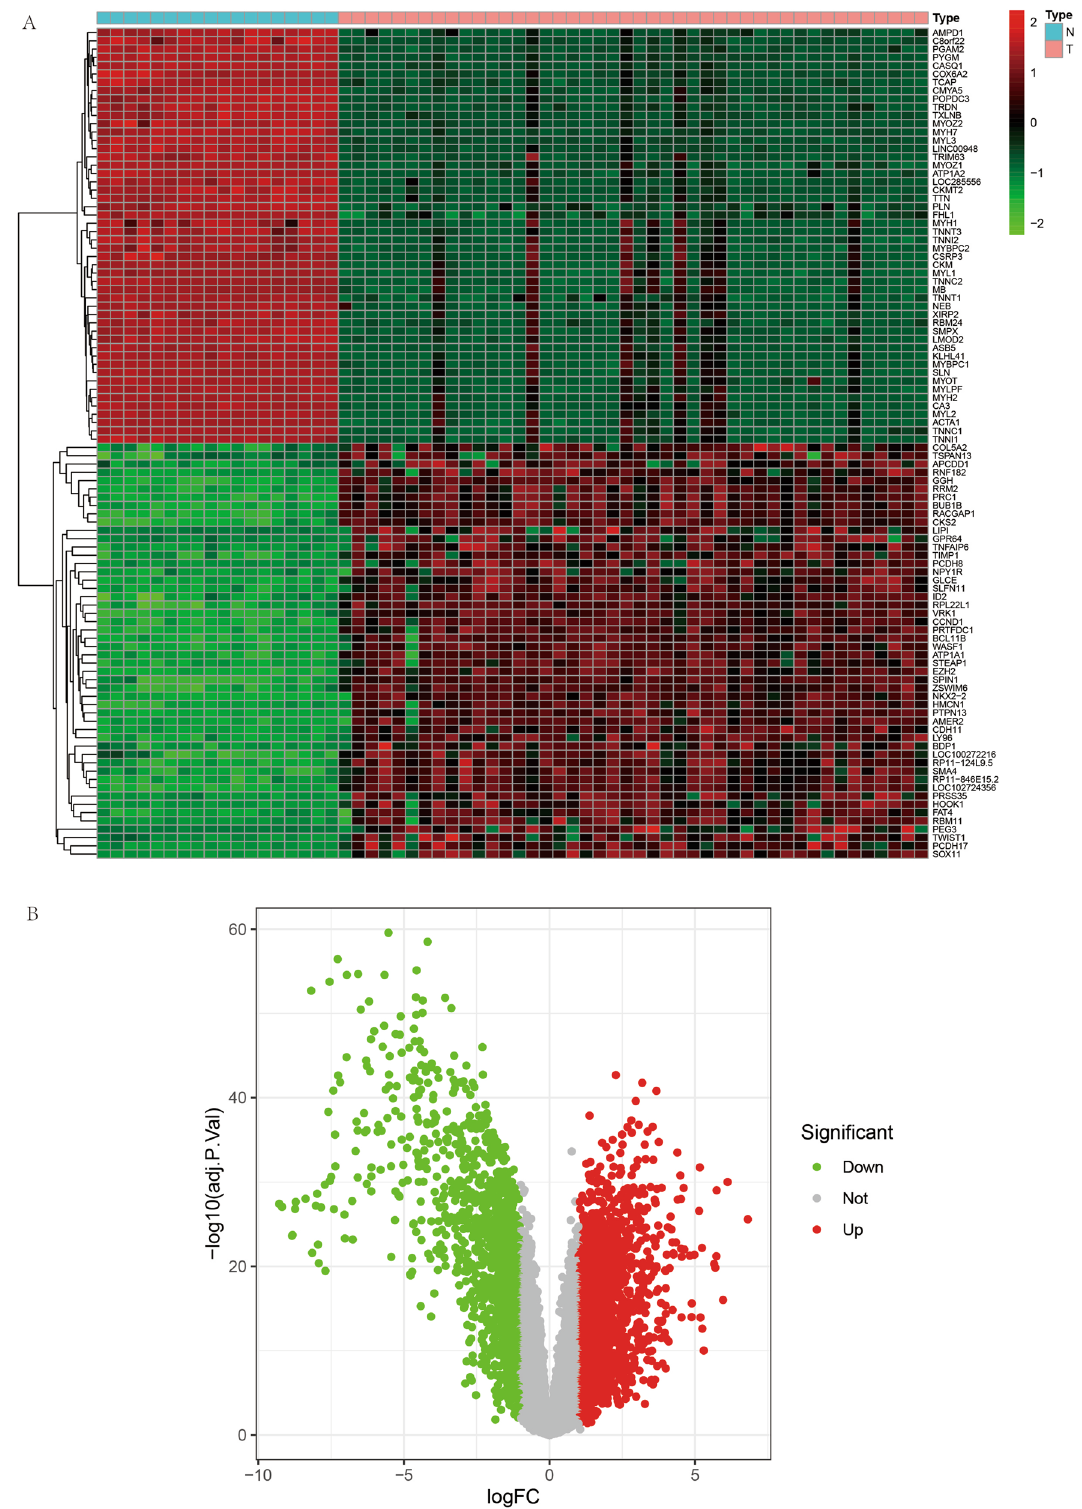
Figure 2. Heat map and volcano plots of differentially expressed genes. ( A ) shows a heat map of the differentially expressed genes. ( B ) shows the volcano map of differentially expressed